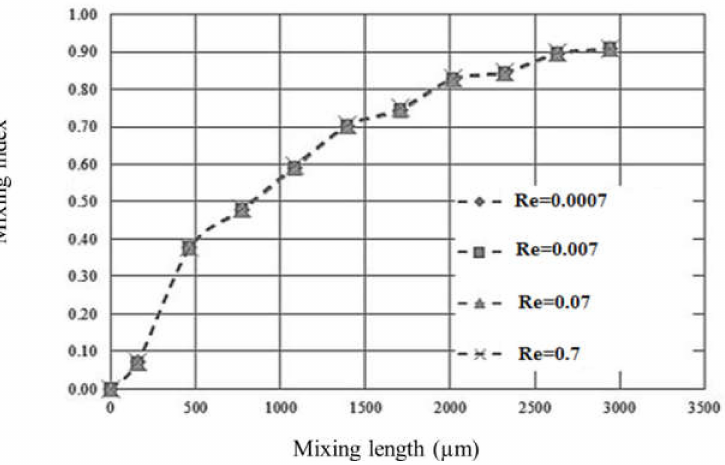
Figure 6. The various mixing indexes of cross-sectional plane versus mixing length at different Re numbers for the